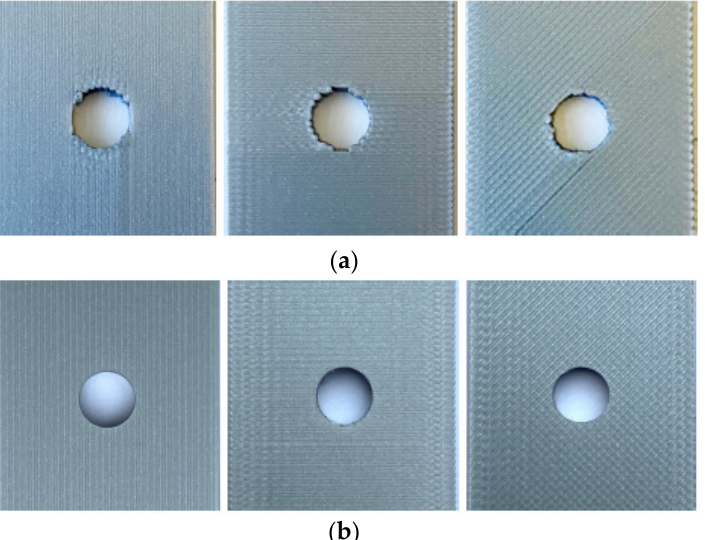
Figure 5. The 6 mm hole diameter samples: ( a ) PH6.0 ( left ), PH6.90 ( middle ), and PH6.45 ( right ); ( b ) DH6.0 ( left ), DH6.90 ( middle ), and DH6.45 ( right ).